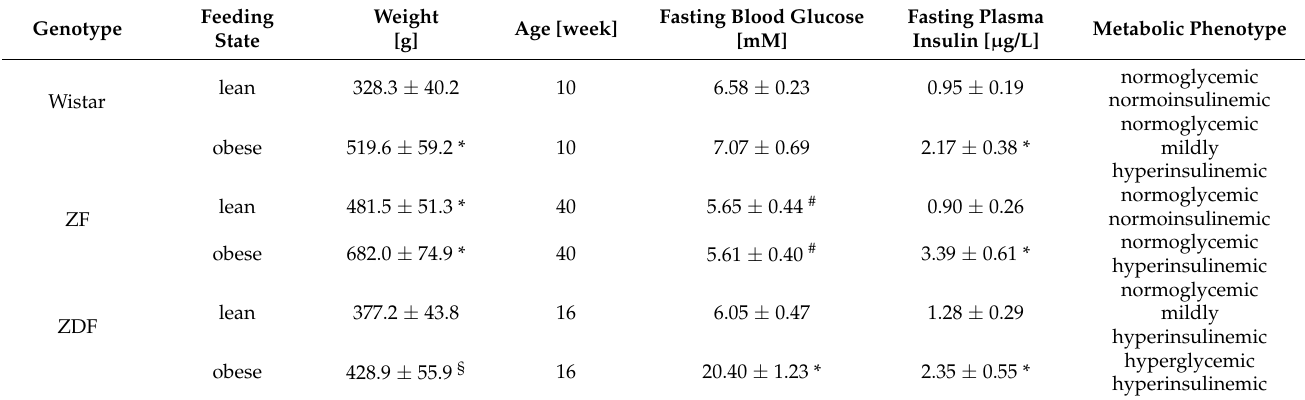
Table 2. Characteristics of the six rat groups. Mean values ± SD ( n = 8) of weight, fasting blood glucose and fasting plasma insulin for each rat group (of given genotype and feeding state) are shown (* p ≤ 0.01, § p ≤ 0.02, # p ≤ 0.05 vs. lean Wistar).